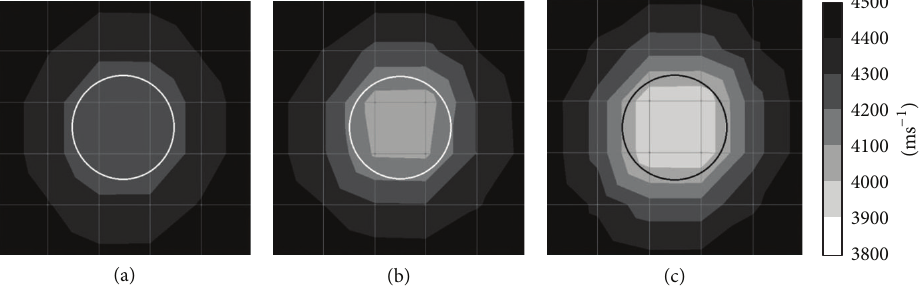
Figure 13: 25 elements: (a) 0% void; (b) 50% void; and (c) 100%